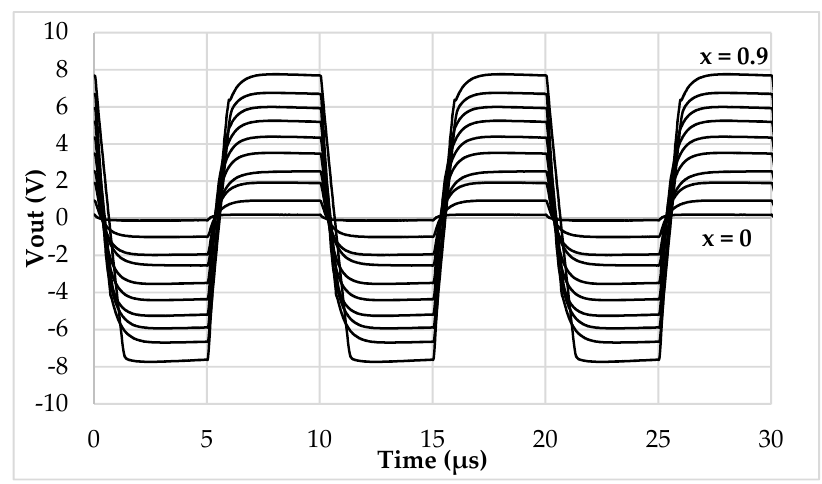
Figure 11. Time domain output voltage of the prototyped interface.